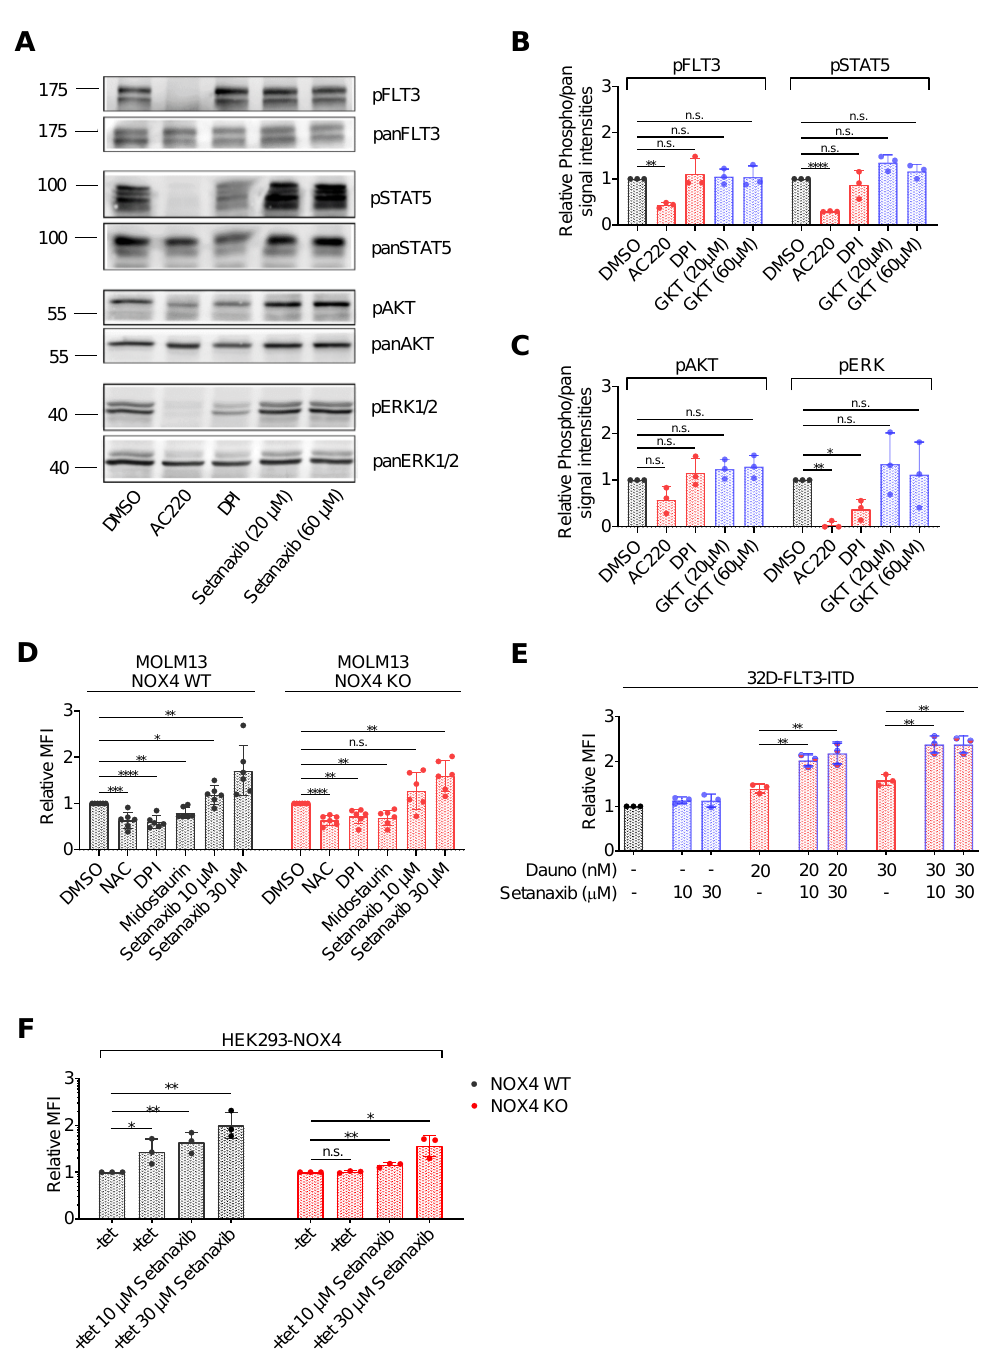
Figure 5. Setanaxib promotes ROS formation elicited by daunorubicin. ( A – C ) MV4-11 cells were treated with the indicated concentrations of the FLT3-ITD inhibitor AC220 (quizartinib, positive control), the general NOX inhibitor diphenyleneiodonium (DPI), or Setanaxib for 4 h in serum-free medium. Thereafter, cells were lysed and lysates subjected to immunoblotting for assessment of pathway activation. Blots were probed with activation-specific antibodies to pFLT3 (pY589/591), pSTAT5 (pY694), pAkt (Ser473), or pErk1/2 (Thr202/Tyr204) antibodies. Subsequently, blots were stripped and comparable loading was validated by reprobing of the membranes with antibodies against FLT3, STAT5, Akt, or Erk as indicated. ( A ) Representative result. ( B , C ) Quantification of three independent experiments for the indicated signaling molecules. Setanaxib (GKT137831) is abbreviated as GKT. Error bars represent mean ± SD. Statistical analyses were carried out with two-tailed t -test. ( D ) MOLM-13 cells were treated with 5 mM NAC (positive control), 500 nM of